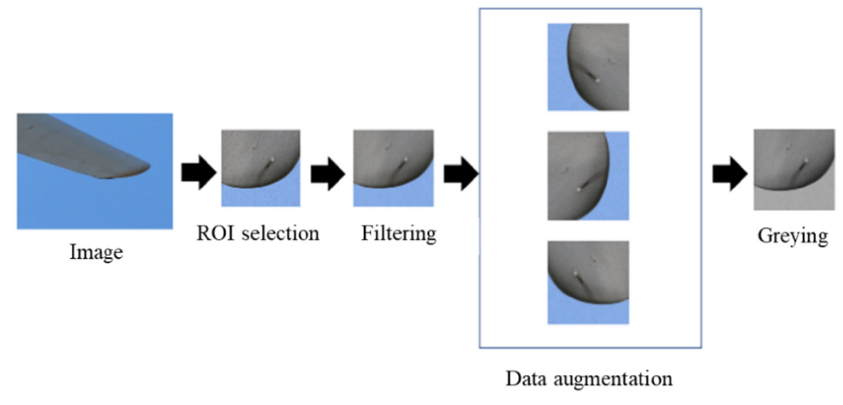
Figure 8. The pre-processing process.